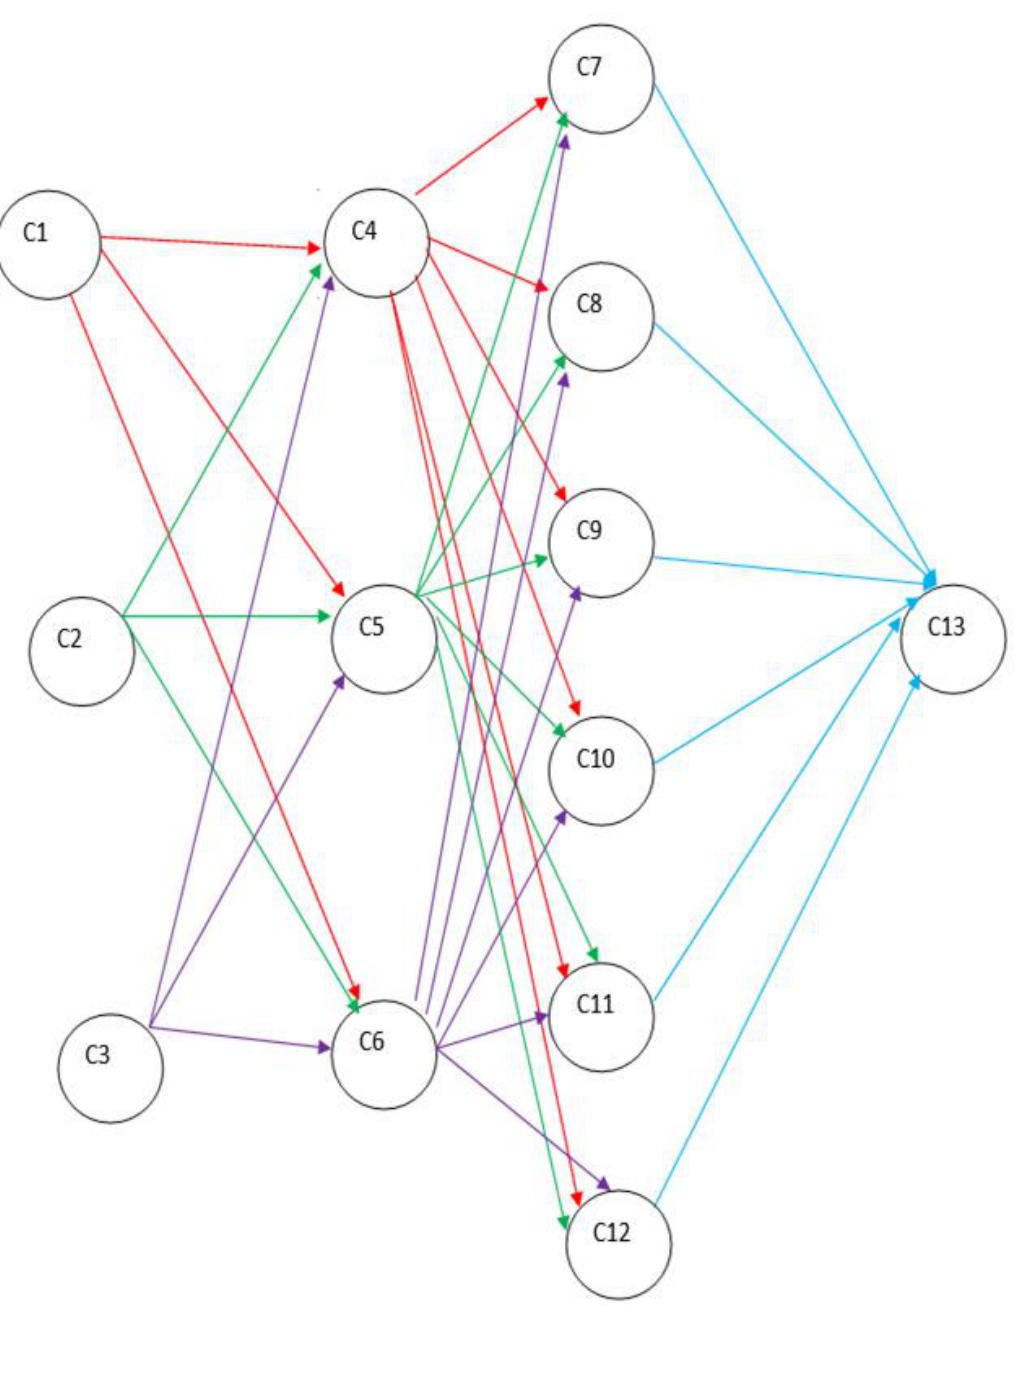
Fig. 4. Association between the